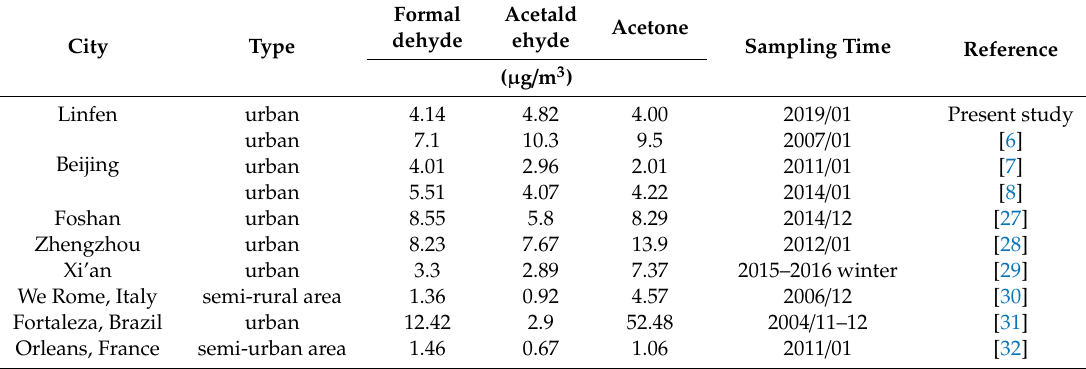
Table 2. Aldehyde and ketone compounds in winter in cities at home and abroad.